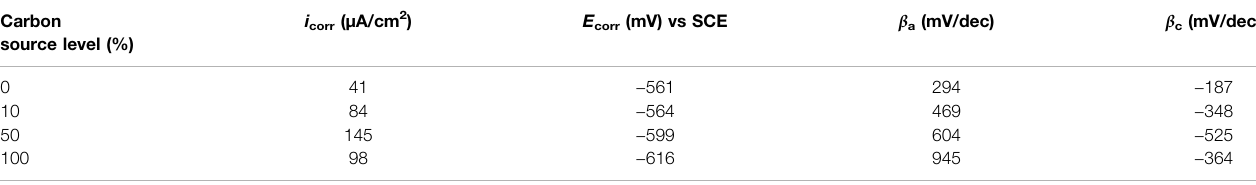
TABLE 4 | Fitted electrochemical parameters from Tafel analysis of Figure 9 . Carbon source level (%)